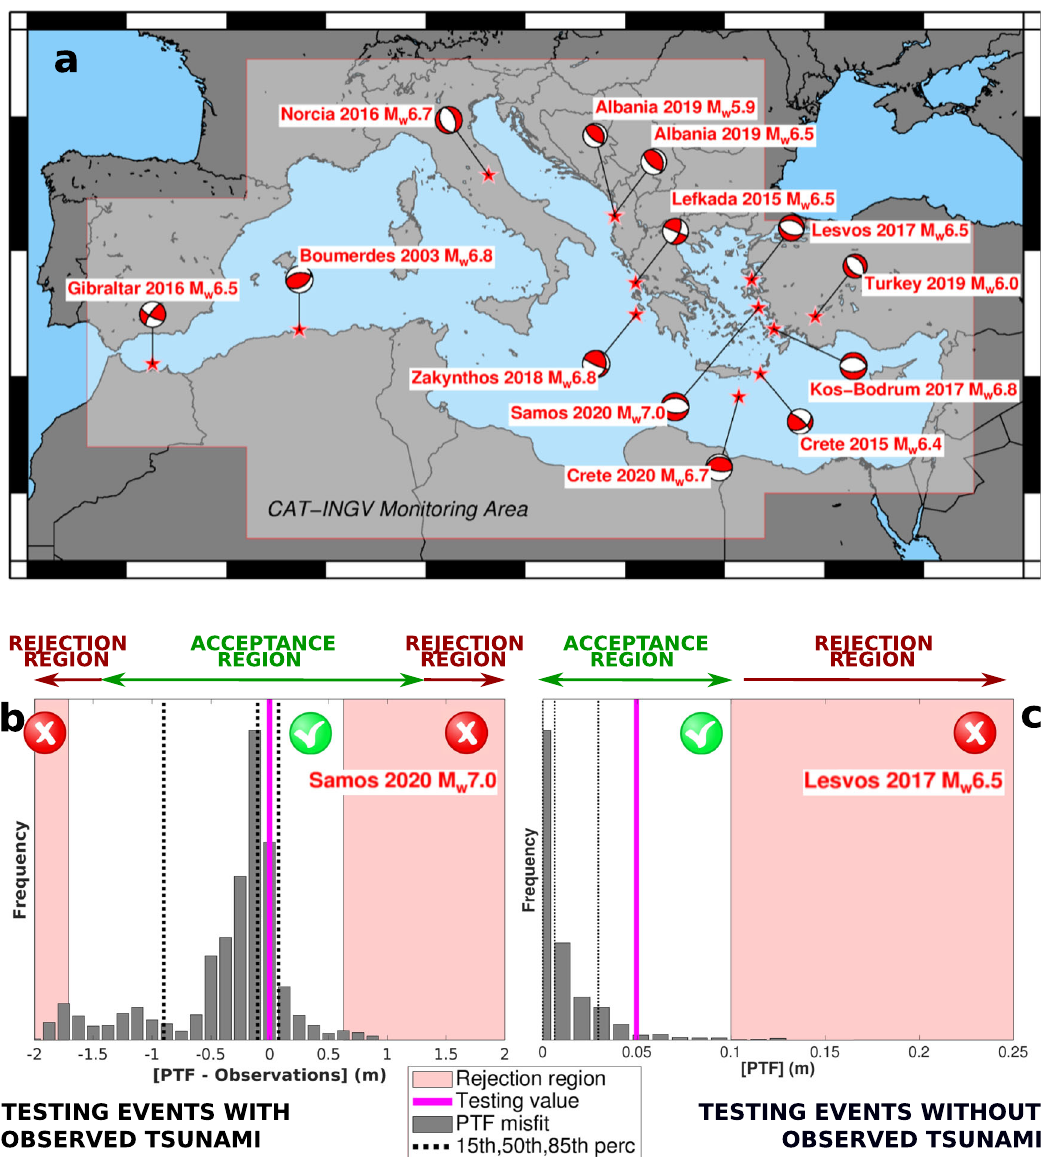
Fig. 5 Testing PTF. a Testing dataset and monitoring area of CAT-INGV; additional details are reported in Supplementary Table 2. b Example of test for events with observed tsunami: the case of 2020 Mw 7.0 Samos-Izmir earthquake. PTF mis fi t distribution ( [PTF-Observations] ) is evaluated as the difference between near-coast wave amplitudes sampled from the PTF source ensemble and observations and staked for all observation points (see Methods). Gray bars report the mis fi t distribution, along with its 15, 50, and 85 percentiles (dashed lines). The model is rejected if the testing value (null mis fi t, purple line) falls in the rejection area (light red area); otherwise, the test is passed. c Example of test for events without observed tsunami: the case of 2017 Mw 6.5 Lesbos earthquake. The PTF distribution ( [PTF] ), obtained sampling from the PTF source ensemble, is expected to encompass small values. The model is rejected if the testing value (the 95th percentile of [PTF] , purple line) falls in the rejection area (light red area: near-coast wave amplitude < 0.1 m); otherwise, the test is passed. To keep spatial correlations, in both [PTF-Observations] and [PTF] the uncertainty in propagation is averaged (see Methods). All the other case studies are reported in Supplementary Figs. 4 and